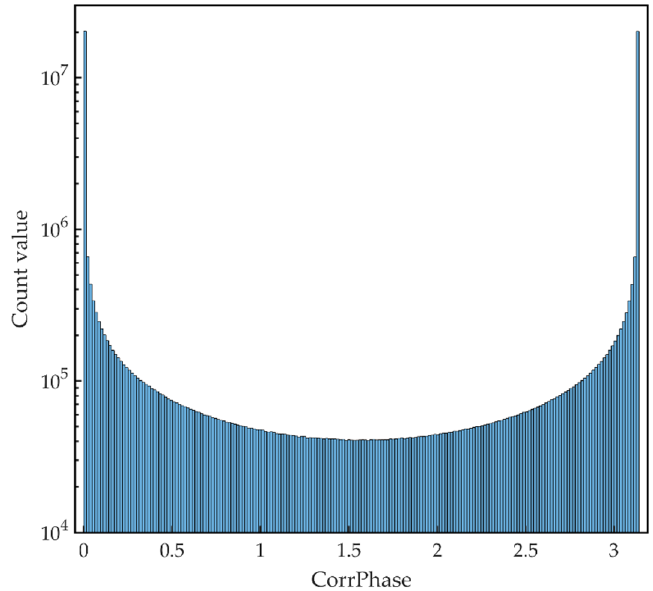
Figure A4. The histogram of CorrPhase of dataset 235.